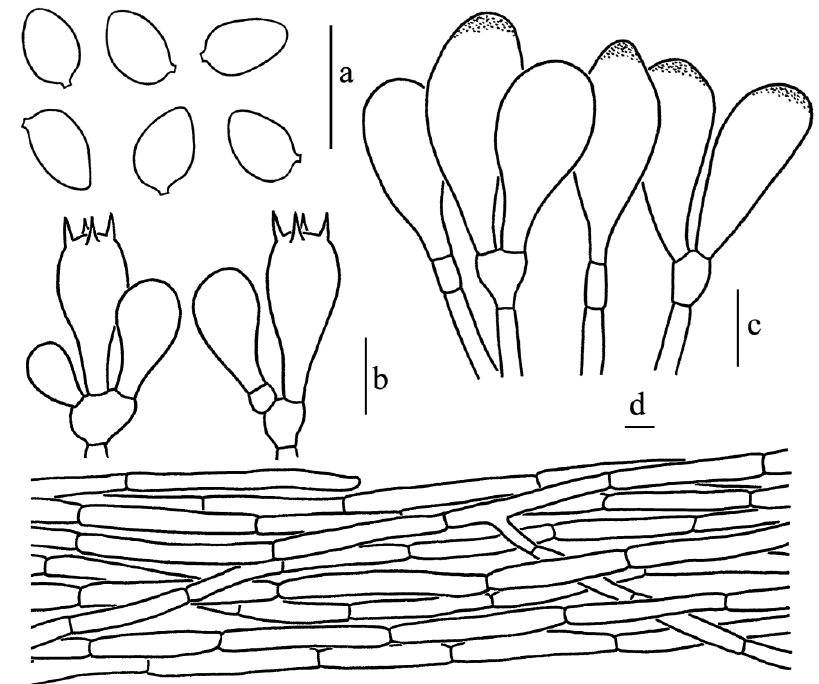
Figure 5. Leucoagaricus atroviridis (SYAU FUNGI 073). ( a ) Basidiospores. ( b ) Basidia. ( c ) Cheilocystidia. ( d ) Elements of pileus squamules. Scale bars: 10 μm.